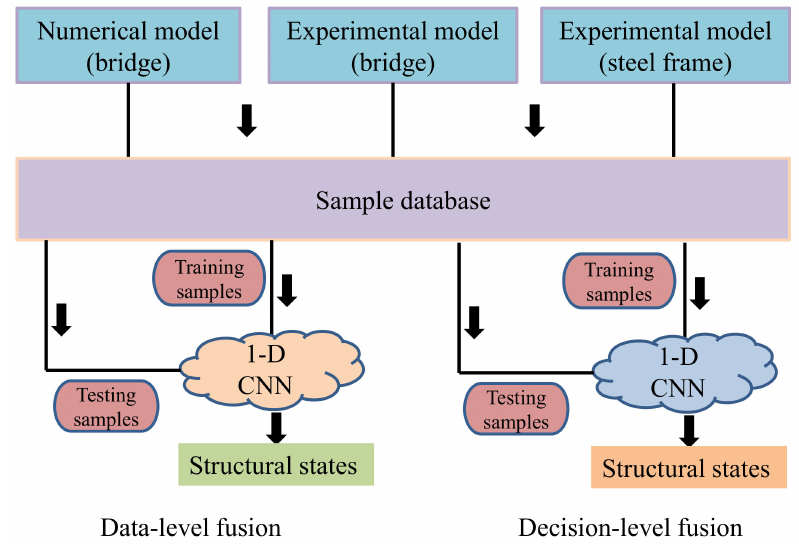
Figure 1. The implementation strategies of the SDD using the 1-D CNN.